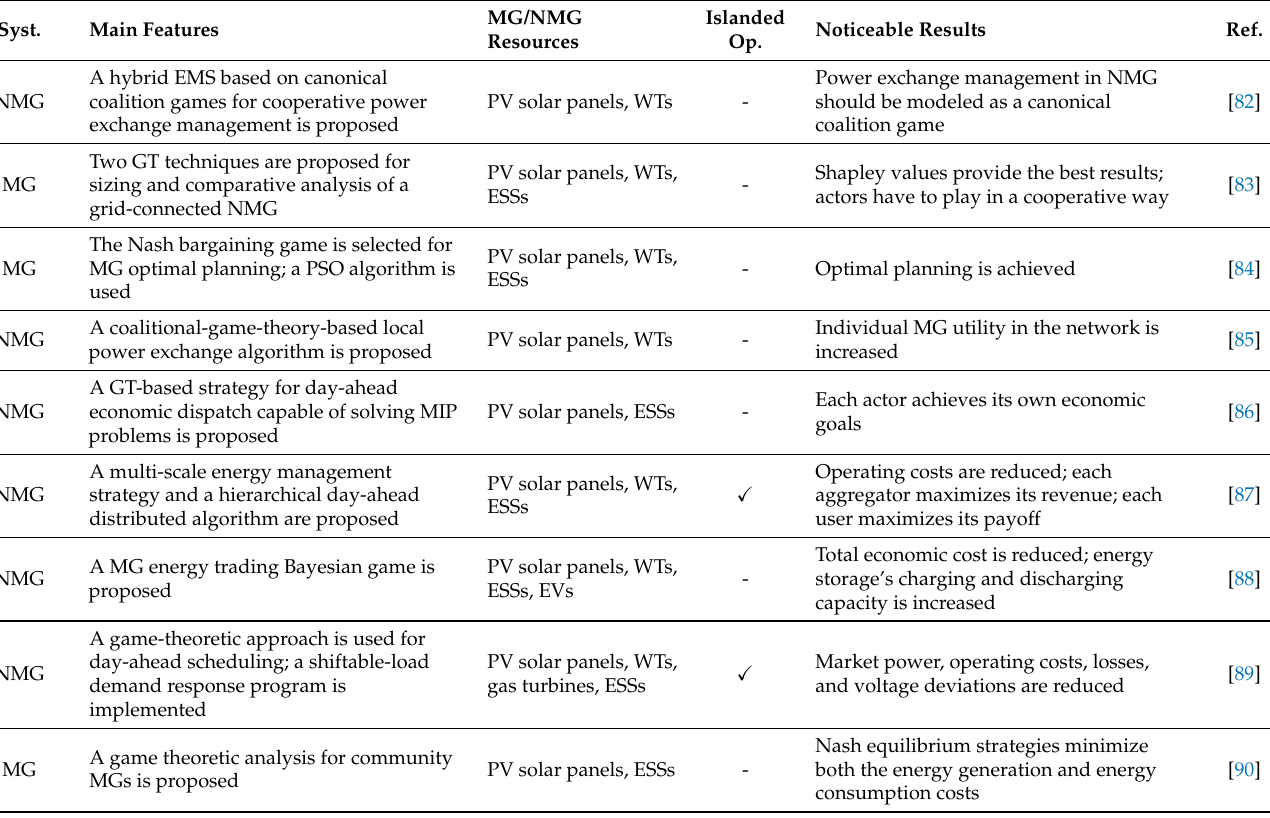
Table 5. A focus on papers dealing with game theory (GT) methods for MG/NMG management. EMS stands for energy management system. ESS stands for energy storage system. MG stands for microgrid. MIP stands for mixed integer programming. NMG stands for networked microgrid. PSO stands for particle swarm optimization. WT stands for wind